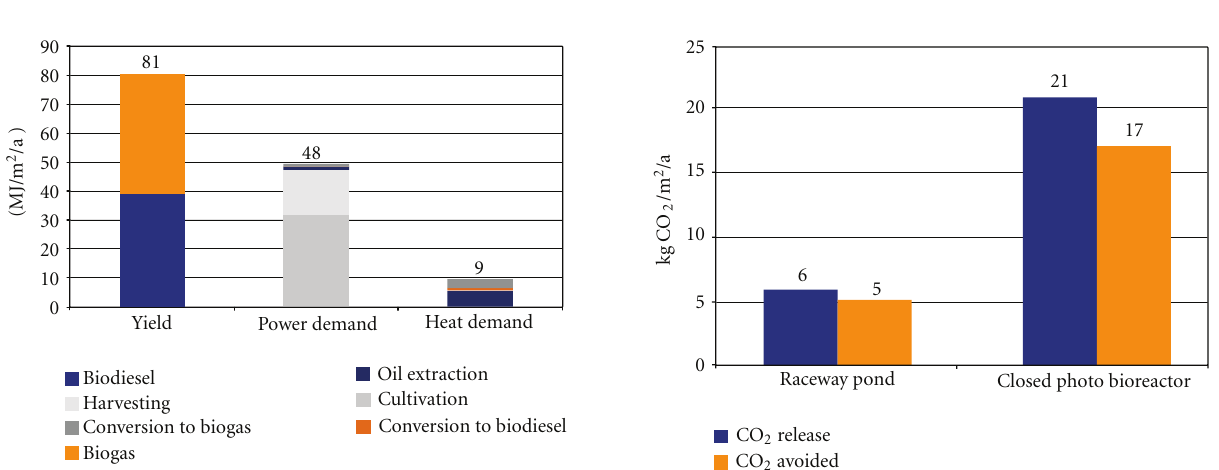
Figure 9: CO 2 emissions released during microalgae biodiesel and biogas production compared to emissions avoided due to substitution of fossil fuels (solar radiation 7,000 MJ/m 2